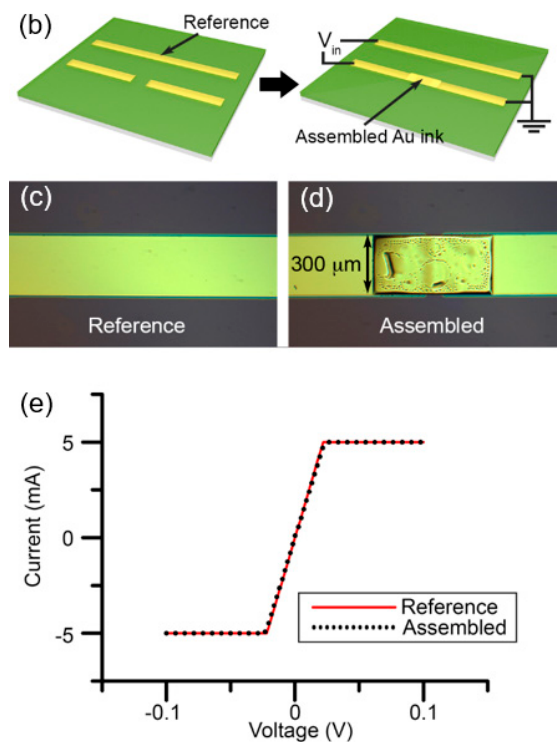
Figure 8. ( a ) A colored SEM image of Au inks (yellow) assembled on an Si strip (grey) which is patterned on SiO 2 (green) for transmission line model (TLM) measurements. ( b ) Schematics of reference and assembled Au lines. ( c , d ) Optical images of a reference Au line fabricated through microfabrication and a connected Au line with an assembled Au ink. ( e ) I–V curves of the reference and assembled Au lines. Reproduced with permission from [35,61].